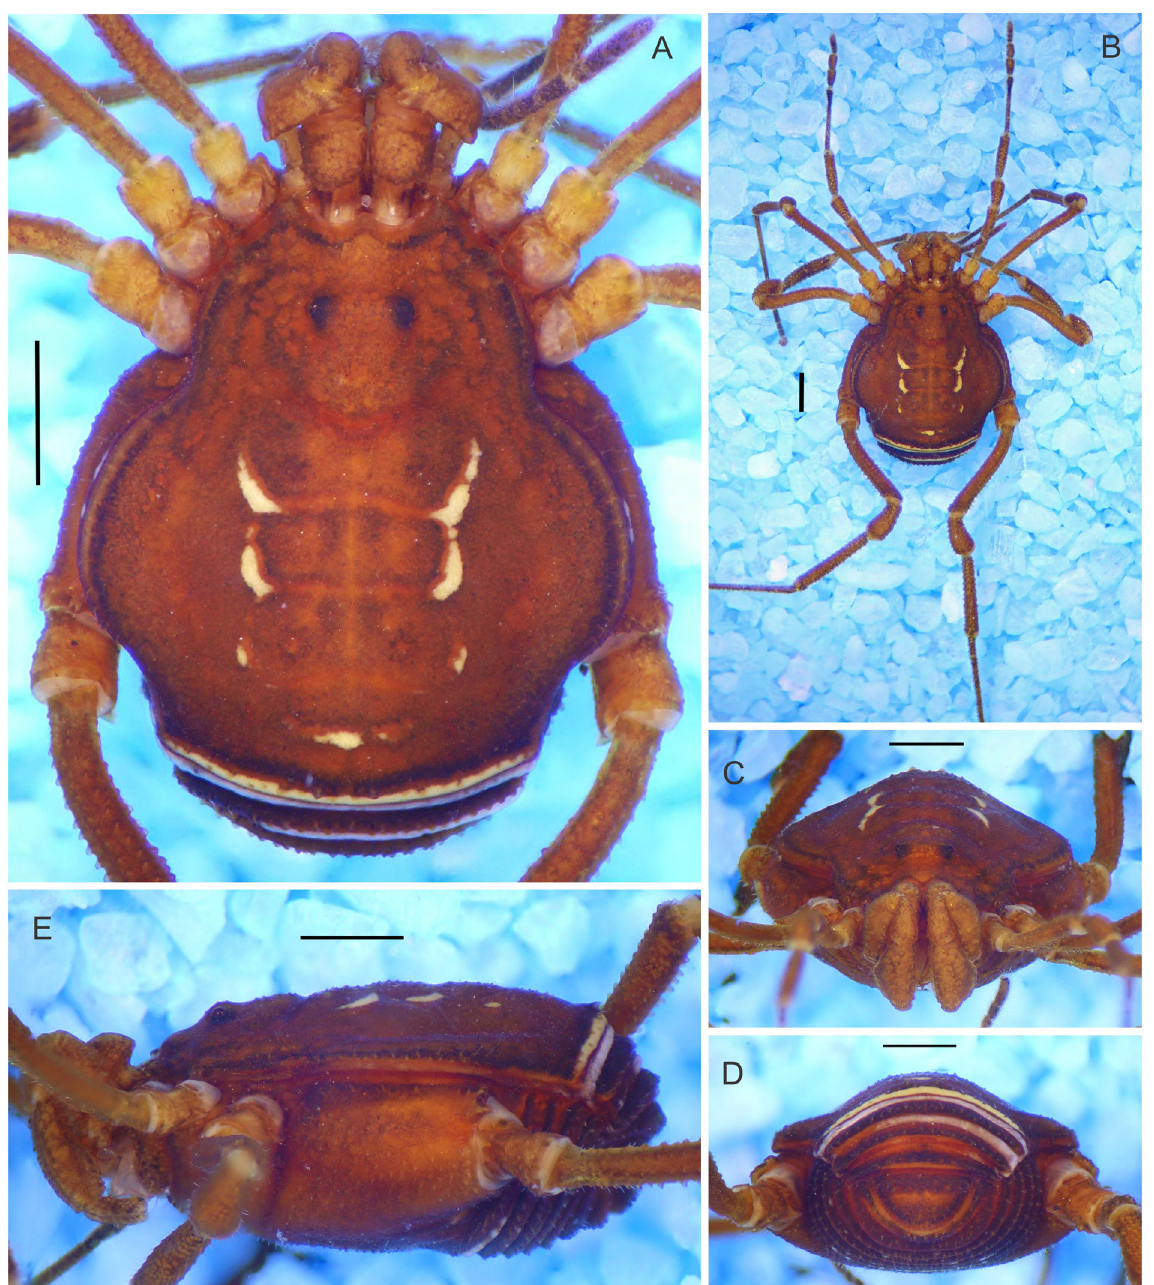
Fig. 27. Eulibitia scalaris (Sørensen in Henriksen, 1932) comb. nov., ♂ (MNRJ 17948), habitus. A . Dorsal view. B . Panoramic, dorsal view. C . Frontal view. D . Posterior view. E . Lateral view. Scale bars: 1